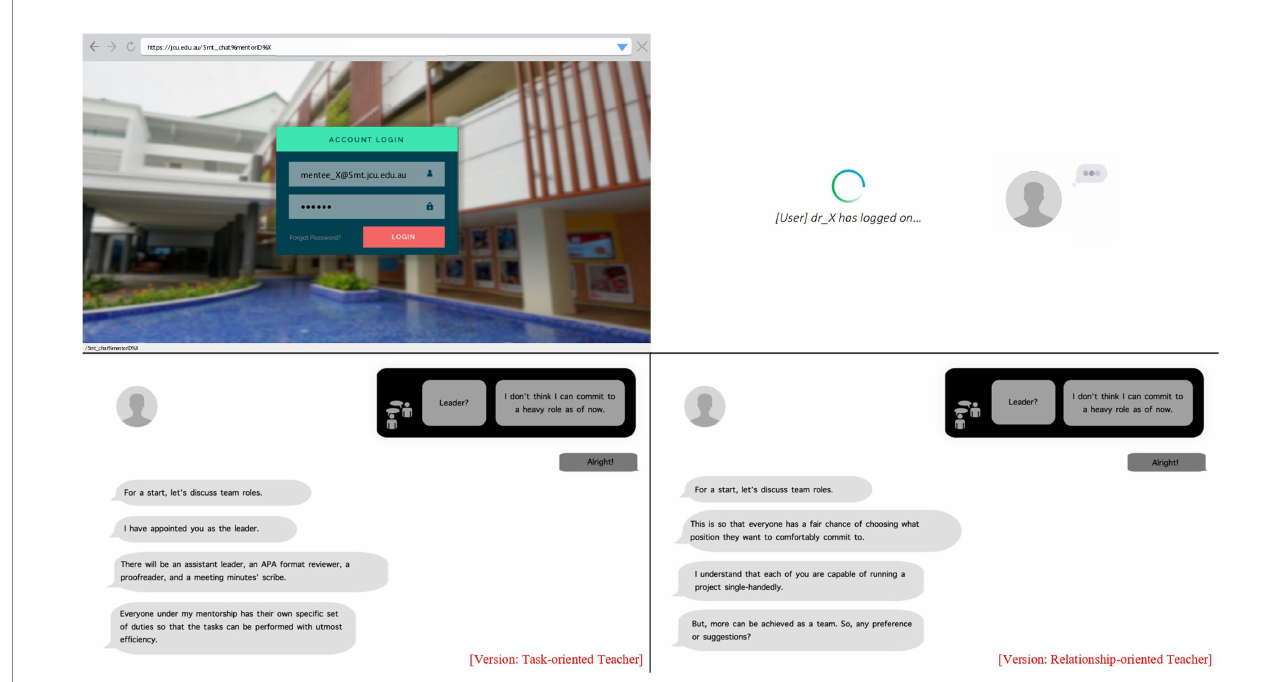
FIGURE 1 Images of the user session (i.e., the login screen of the online chat, loading, typing animations) and sample block of interaction between the (task-oriented vs. relationship-oriented) teacher and participant in the online